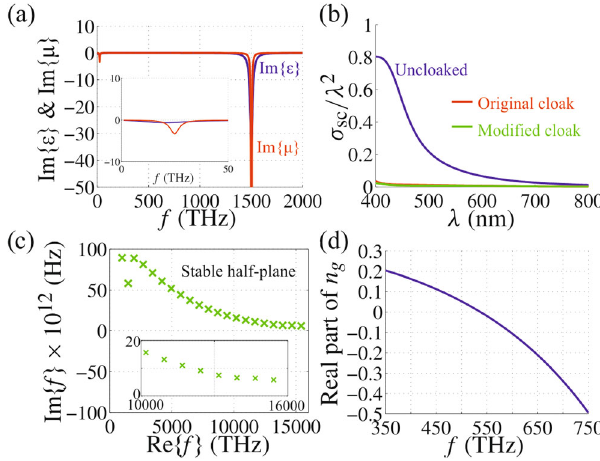
Fig. 1 Broadband, stable, causal, fast-light aided invisibility cloaking of electrically small objects. a Imaginary parts of the (relative) permittivity, ε , and permeability, μ , versus frequency of the gain doublet cloaking medium. The inset shows the same graph focused around the fi rst resonance. b Scattering-cross-section performance across the visible regime of the cloak of ref. 2 (red line) and of the cloak with the parameters of a (green line). c Poles of the electric dipolar scattering coef fi cient on the complex plane, for frequencies up to ~16,000 THz. All poles lie on the upper (stable) half-plane, and the last pole that is technically possible to identify reliably 4 – 6 is well above zero {Im{ f i } ~ 5,84×10 12 }. The inset shows the same graph but focused around the end of the curve. d Group refractive index in the cloaking layer of a , showing that the group velocity in this medium is superluminal (0 < n g < 1), or even negative ( n g < 0), in the visible band targeted for invisibility in, both, ref. 2 and